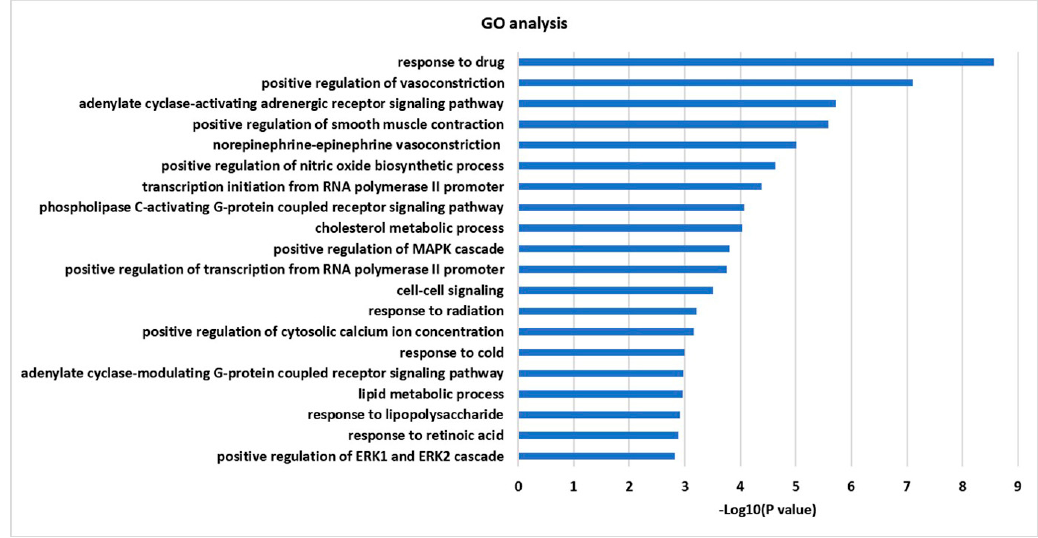
Figure 2. GO enrichment analysis for 21 targets.